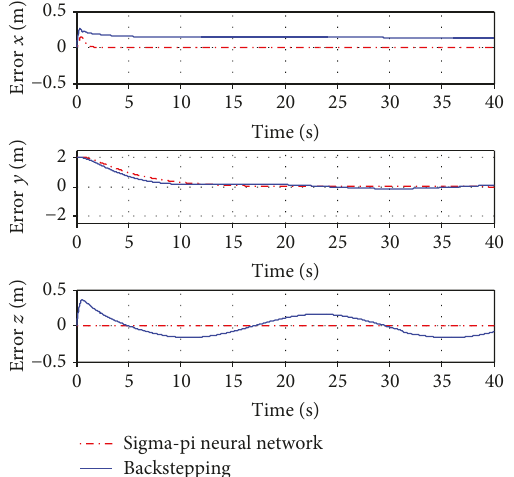
Figure 8: Curves of trajectory tracking error.